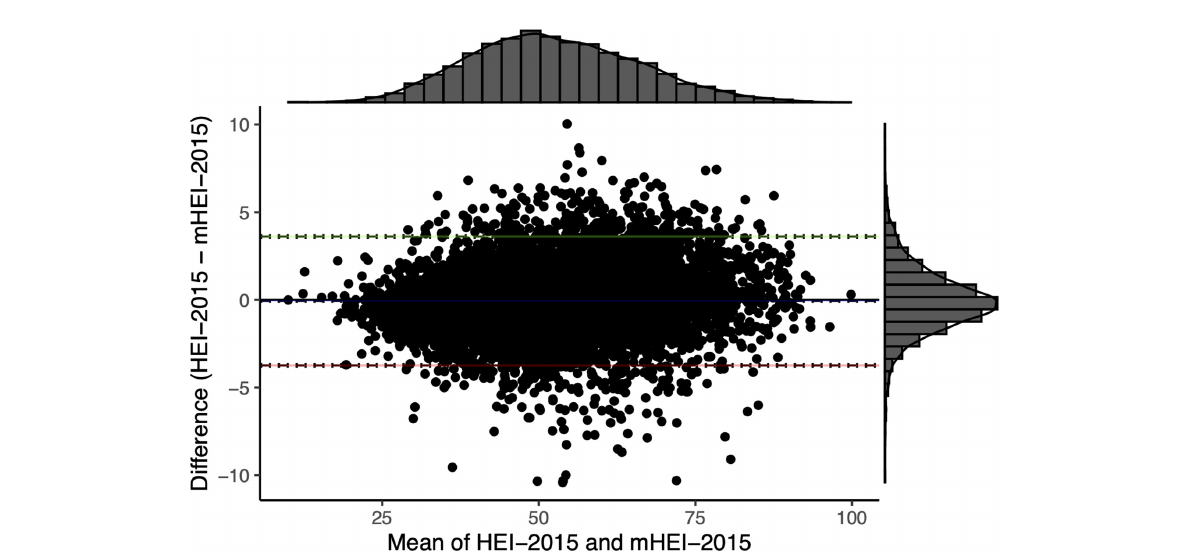
FIGURE3 Bland–Altman plot for comparison of HEI-2015 and mHEI-2015 of NHANES 2015/2016 ( n = 7922). The histograms display the distribution of the mean and the difference of the total scores of the two indices. The blue line represents the mean difference (–0.06 [–0.02; –0.10]). Green